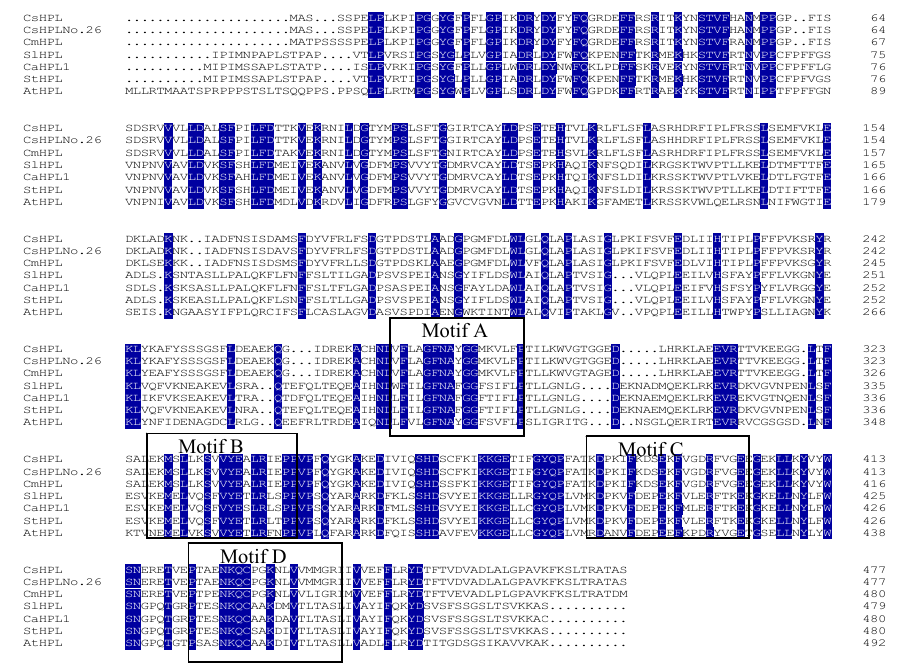
Figure 2. Amino acid sequence homology between cucumber and other HPL. CsHPL